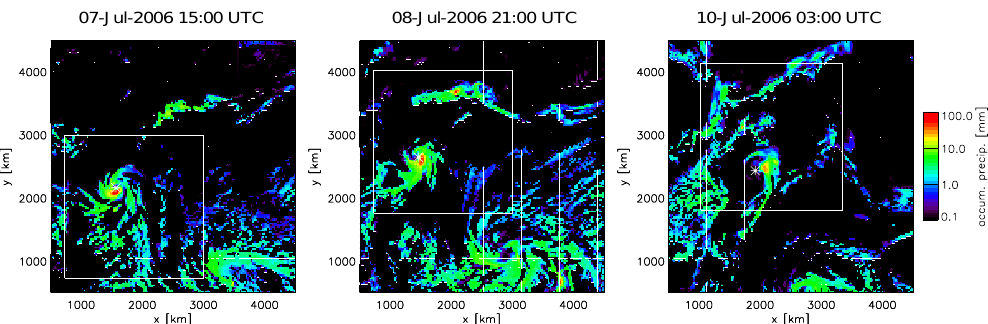
Fig. 11. Accumulated precipitation of the last hour before the center time of each simulation period. The white frame indicates the analysis region and the white asterisk the typhoon